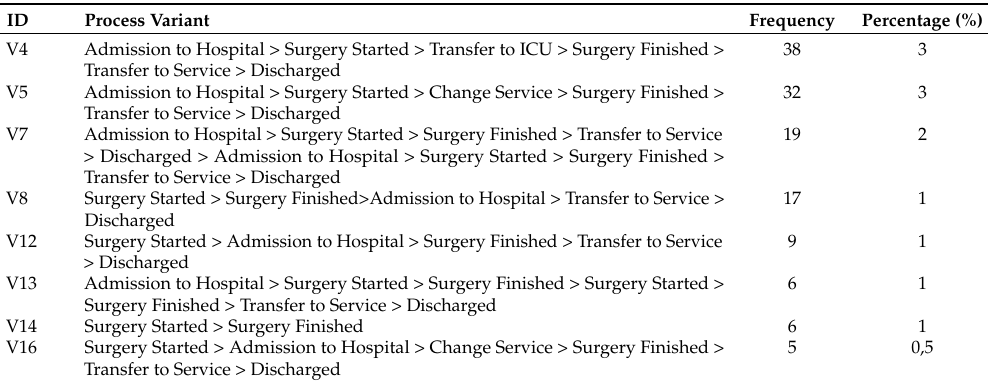
Figure 2. Simplified Process Map of Surgery Process. Table 8. The most non-fitting process